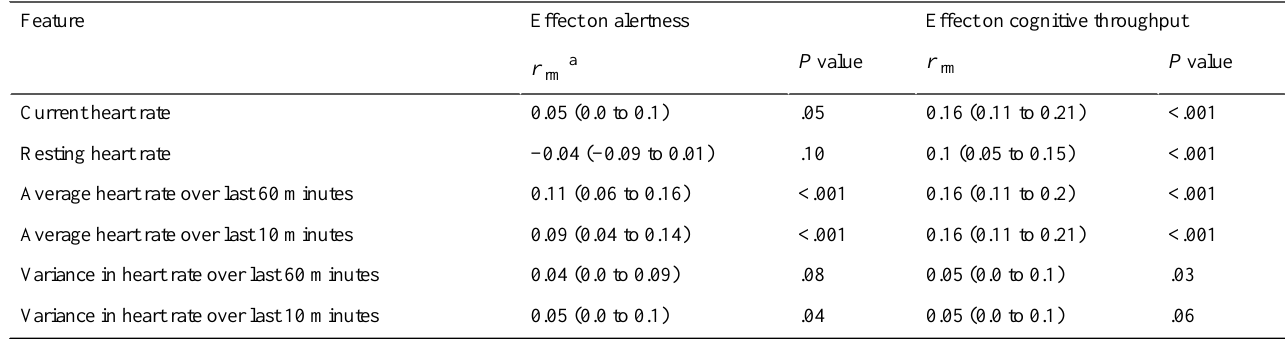
Table 9. Effect of heart rate on momentary alertness and cognitive throughput.